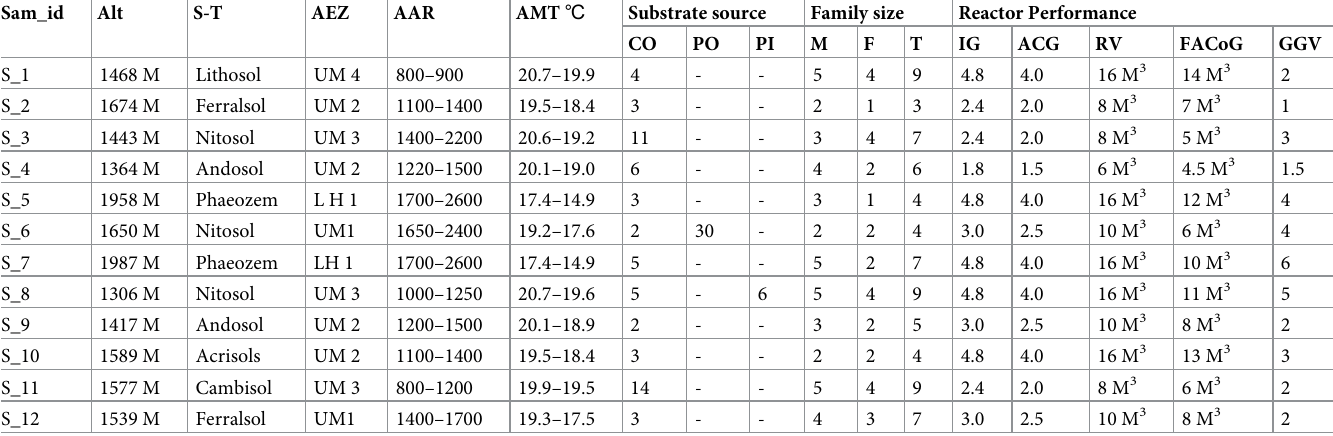
Table 3. The ArcGIS software and the questionnaire generated environmental variables and phenotypic traits for the sampled treatments within the identified blocks of